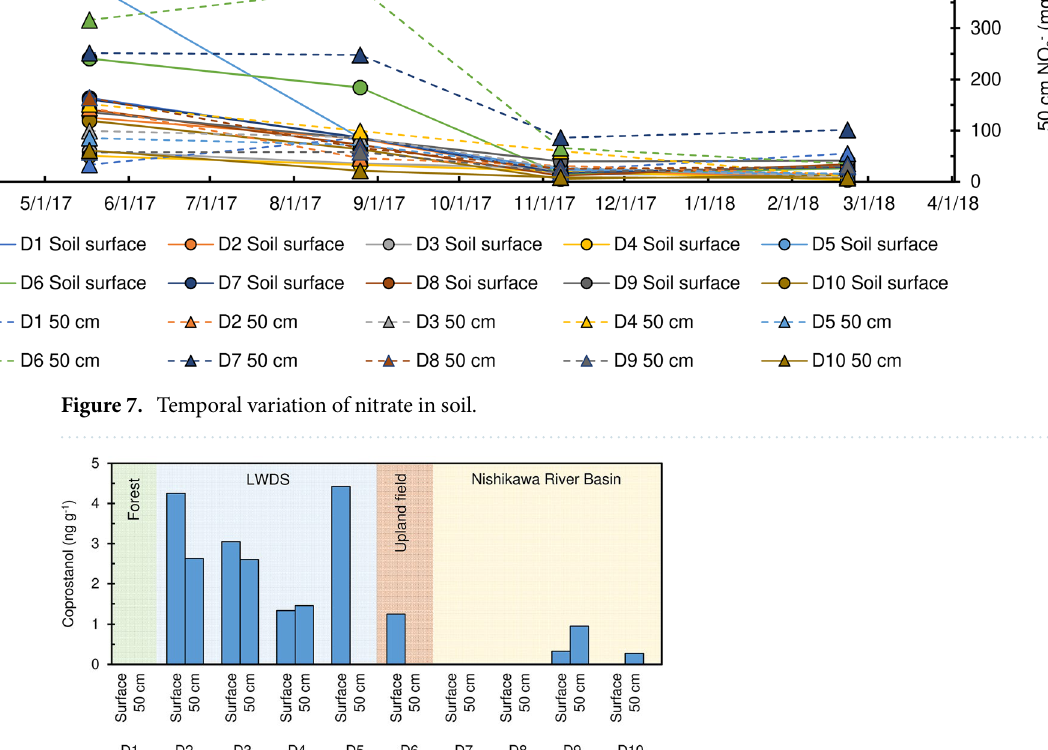
Figure 8. Water soluble coprostanol in soil (May,